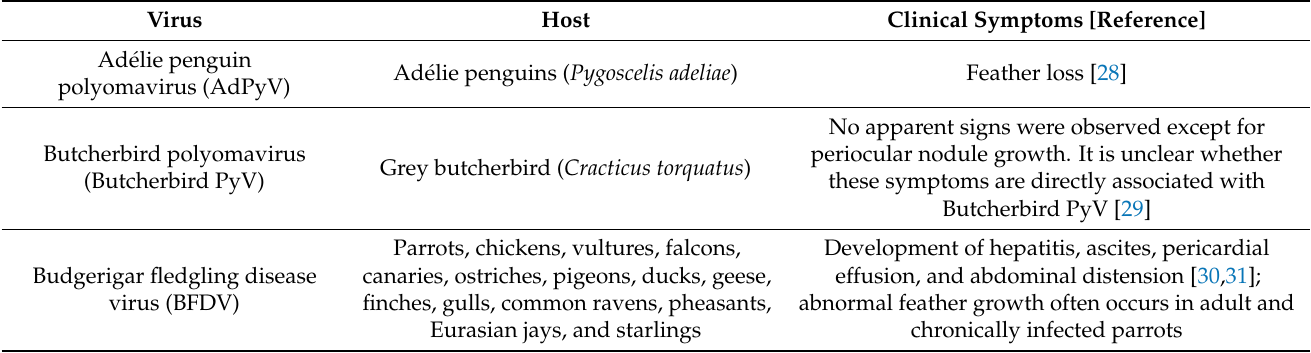
Table 2. Overview of avian polyomaviruses with their hosts and clinical symptoms